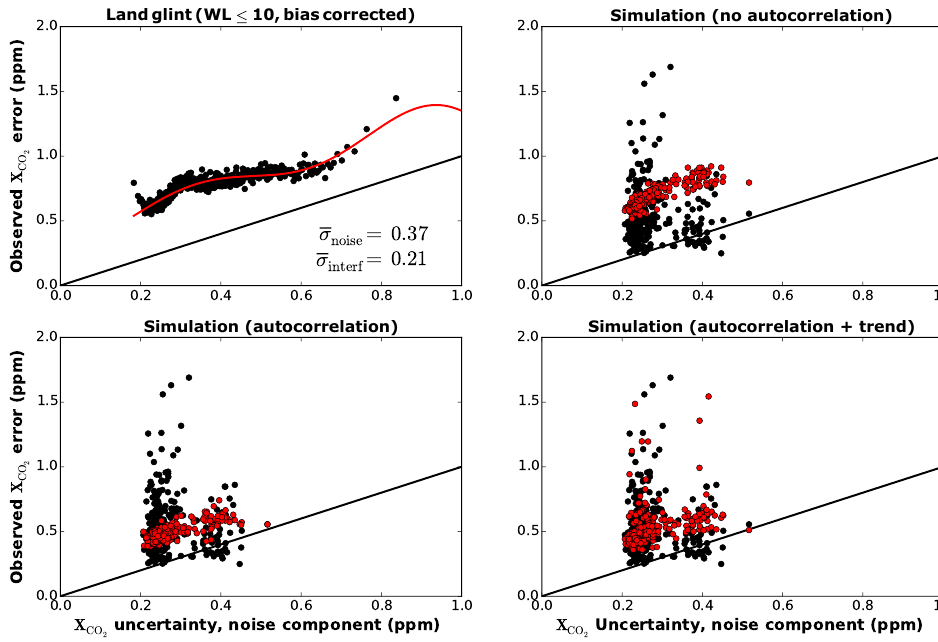
Figure 2. Observed and modeled distributions for land-glint